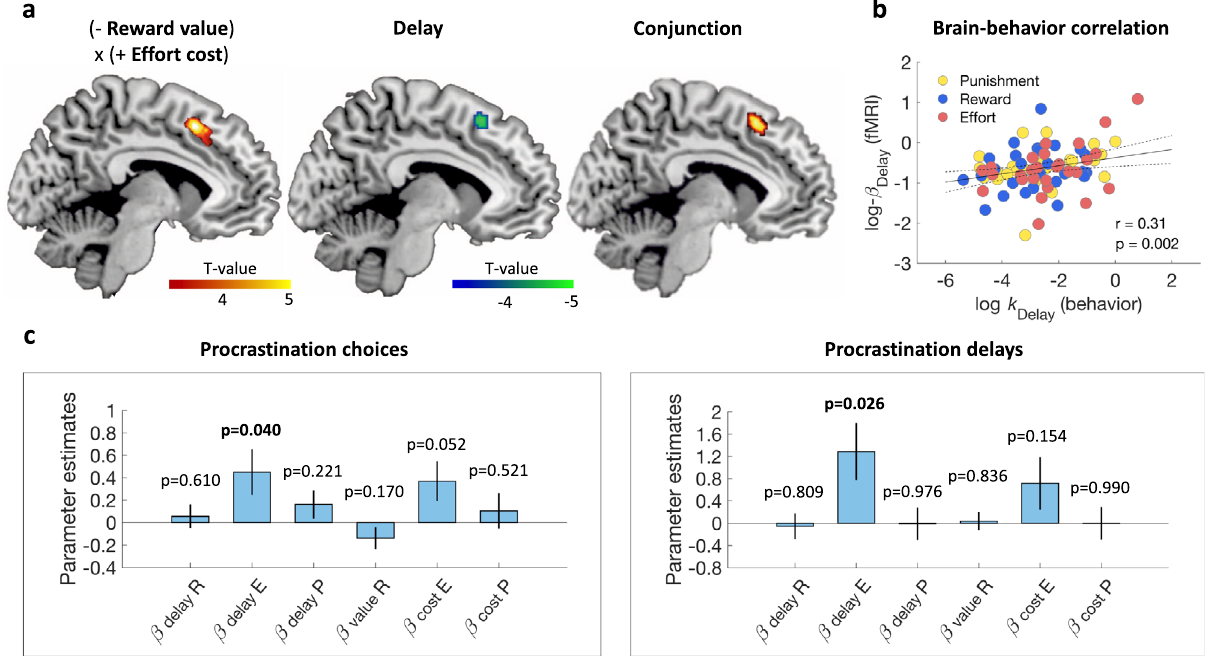
(undiscounted) value or cost of reward, effort, and punishment, obtained from fi tting a linear model to procrastination level observed either in the lab choice task (preference for ‘ tomorrow ’ options) ( n = 27) or at home (delay in returning administrative forms) ( n = 23). Note that neural activity was recorded during intertemporal choices, independently from the procrasti- nation behavior assessed in the lab or at home. Error bars represent SD; signi fi cance values are based on two-tailed one-sample t